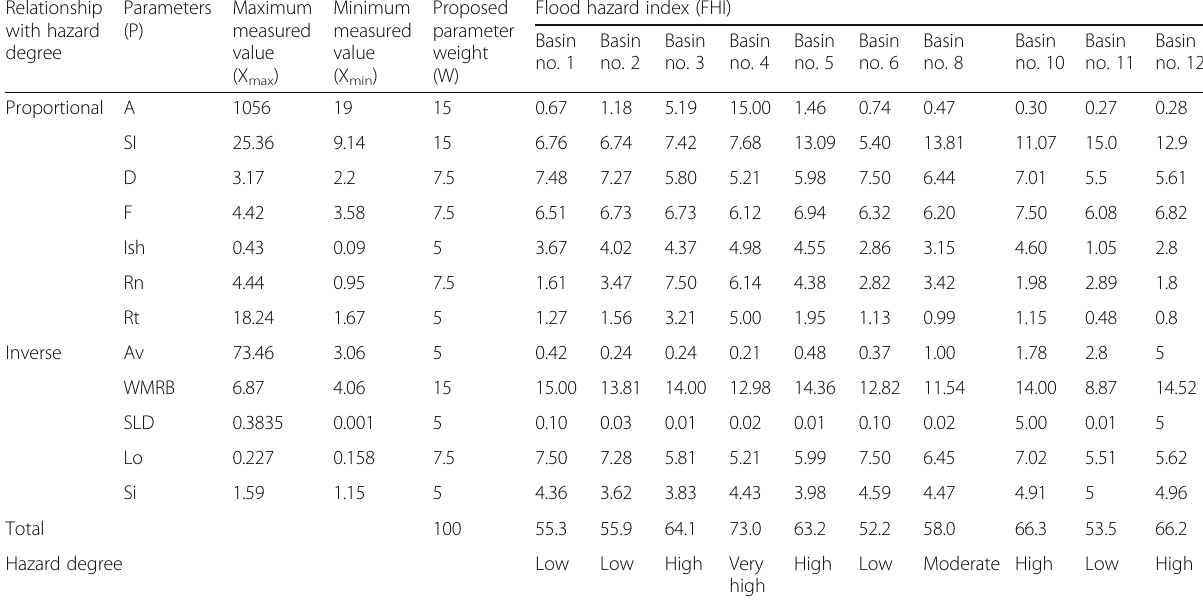
Table 3 Calculations of floods hazard index (FHI) of each basin Relationship Parameters with hazard degree